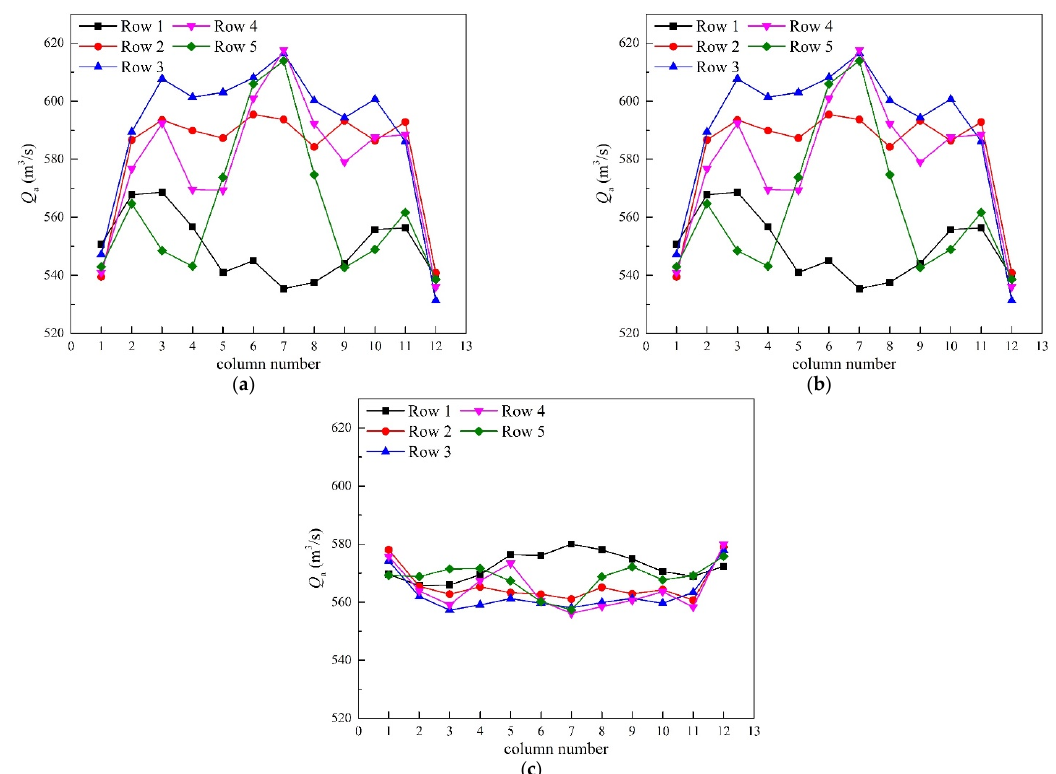
Figure 6. Distribution of volumetric flow rate of the fans under windless condition: ( a ) Design case; ( b ) Str-1 case; ( c ) Str-2 case.